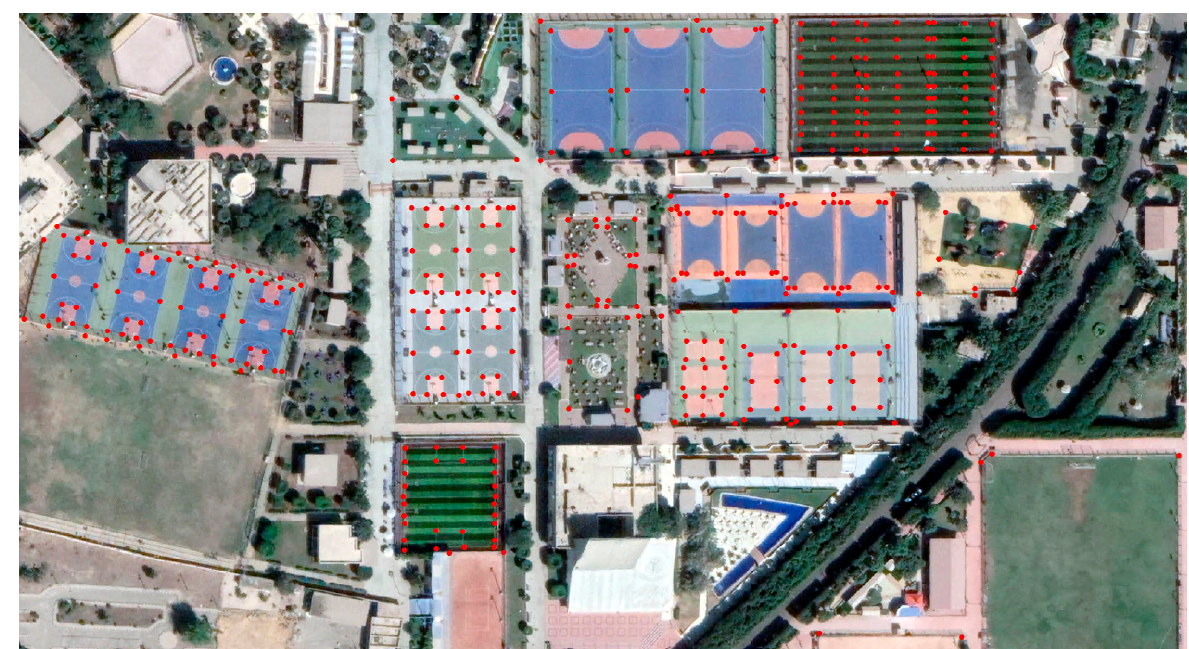
Figure 2. The athletic area where the topographical survey was conducted.